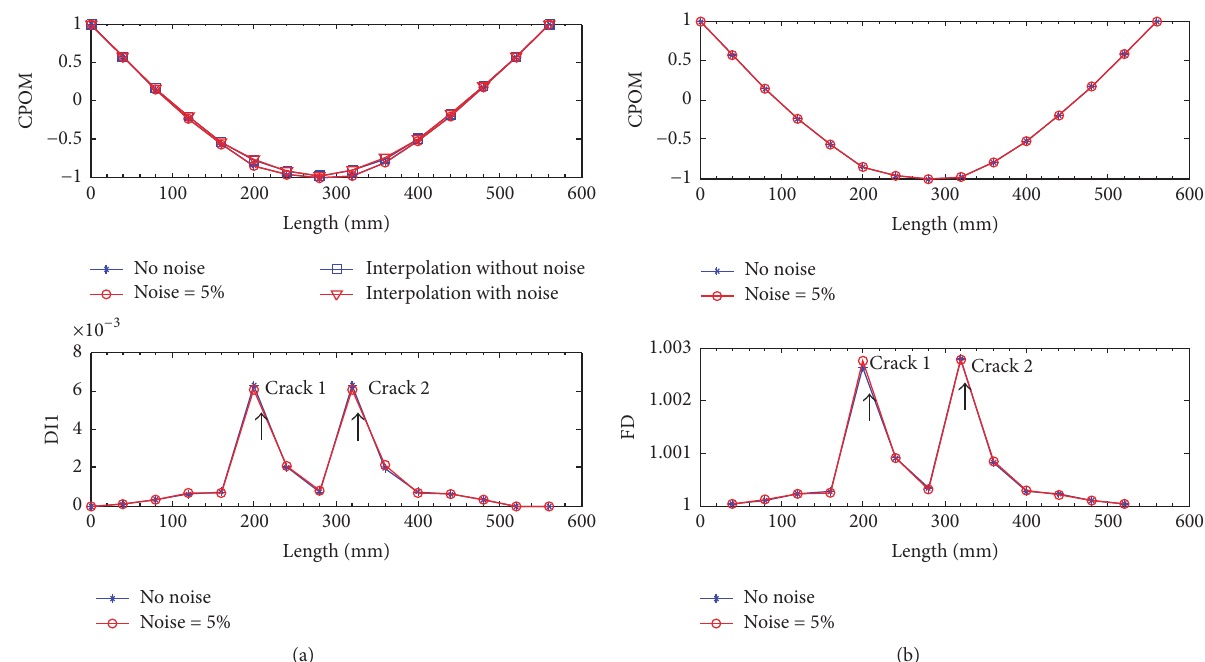
Figure16:Localizationresultsofdouble-crackedrotorwithfewersensorsincase3.(a)LocalizationusingGSMbylineargappedinterpolation. (b) Localization using